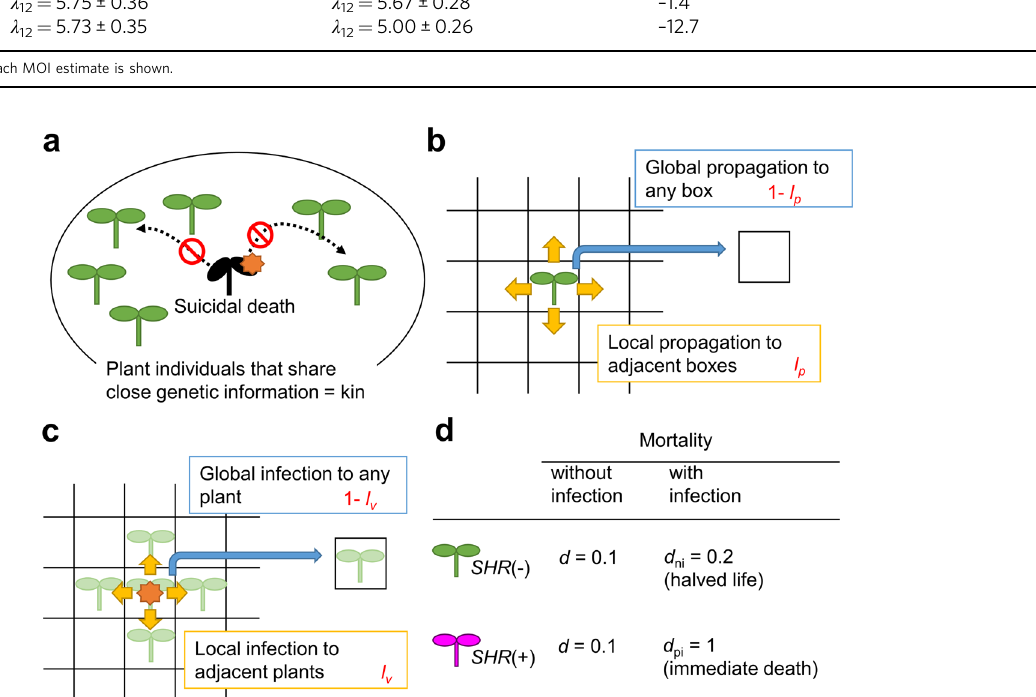
Fig. 5 Conceptual model for a suicidal population resistance via SHR that may protect next of kin. a Protection of adjacent kin plants by suicidal death. b Local and global propagation of plants. c Local and global propagation of virus. d Mortality of SHR ( – ) and SHR ( + ) plants with and without virus infection. Parameter values were set to answer the question: whether it is more fi t to suffer lower reproduction due to viral infection, or to induce inef fi cient resistance against the virus, and, by opposing, end